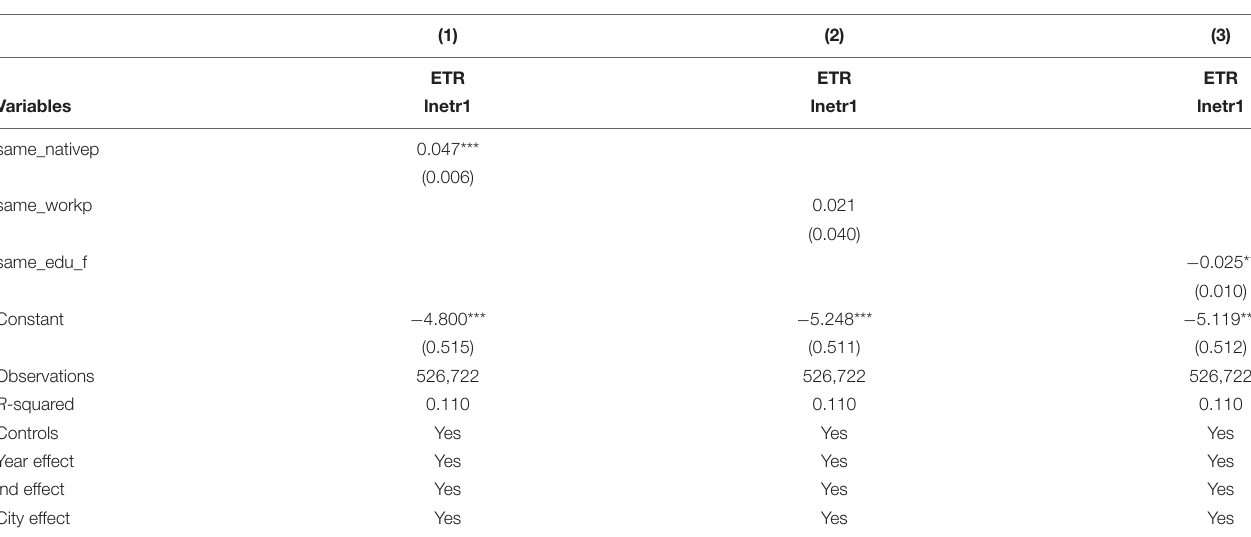
TABLE A1 | Regression analysis grouped by different types of social capital.